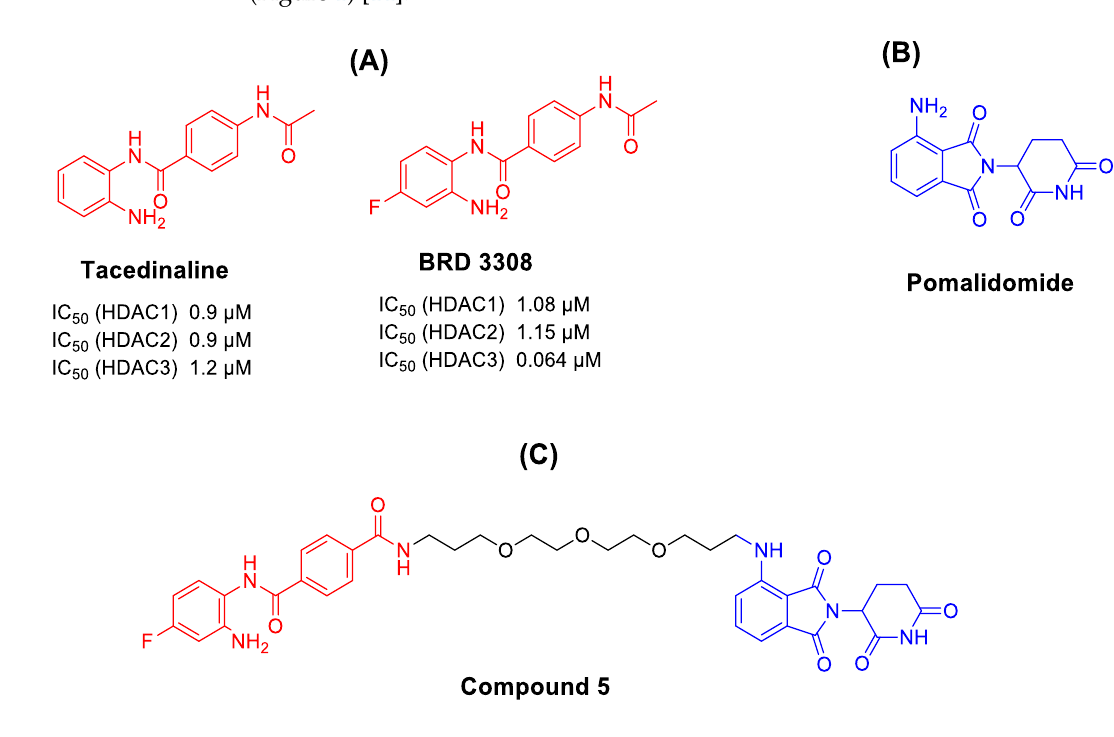
Figure 1. Design of HDACs-PROTACs. ( A ) Examples of 2-aminobenzamide-based HDAC inhibitors. ( B ) Example of CRBN-based E3 ligase ligand. ( C ) Our designed HDAC-PROTACs.